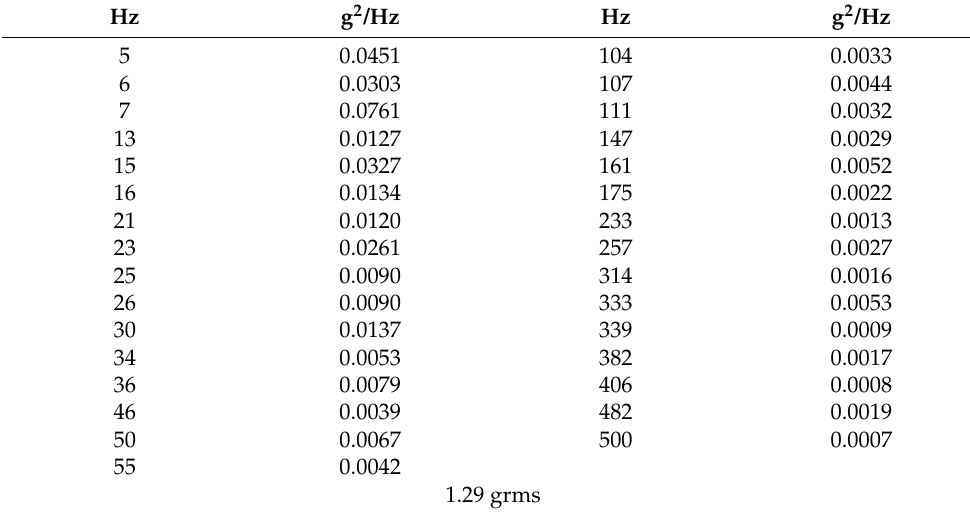
Table A1. GJB150.16A-2009 C.7 Vibration Environment Inflection.